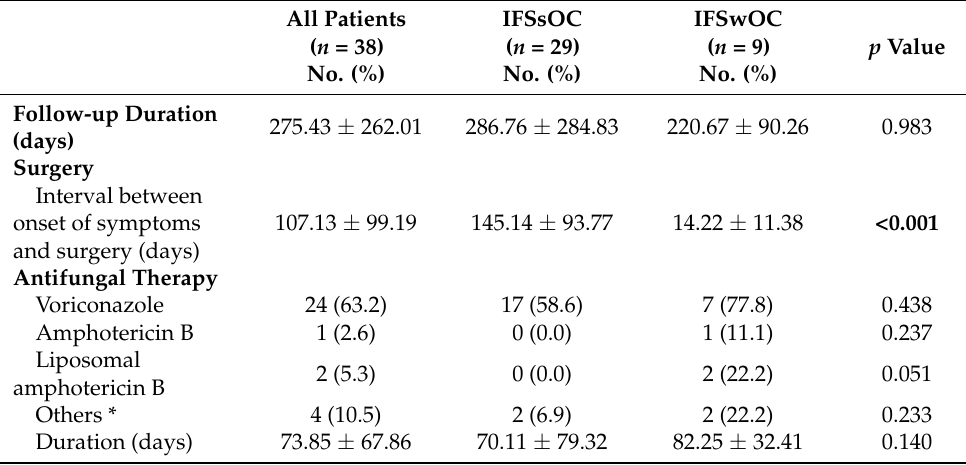
Table 2. Treatment and Outcome.